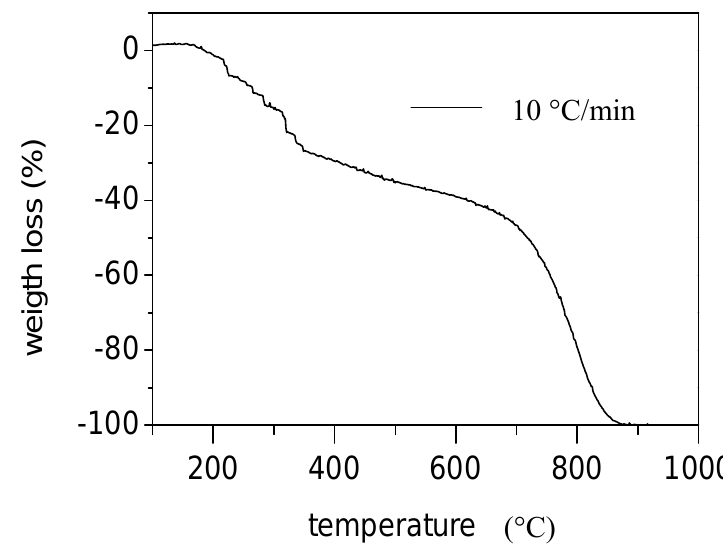
Figure 1. Thermo Gravimetric Analyzer (TGA) analysis of Graphite Intercalation Compounds